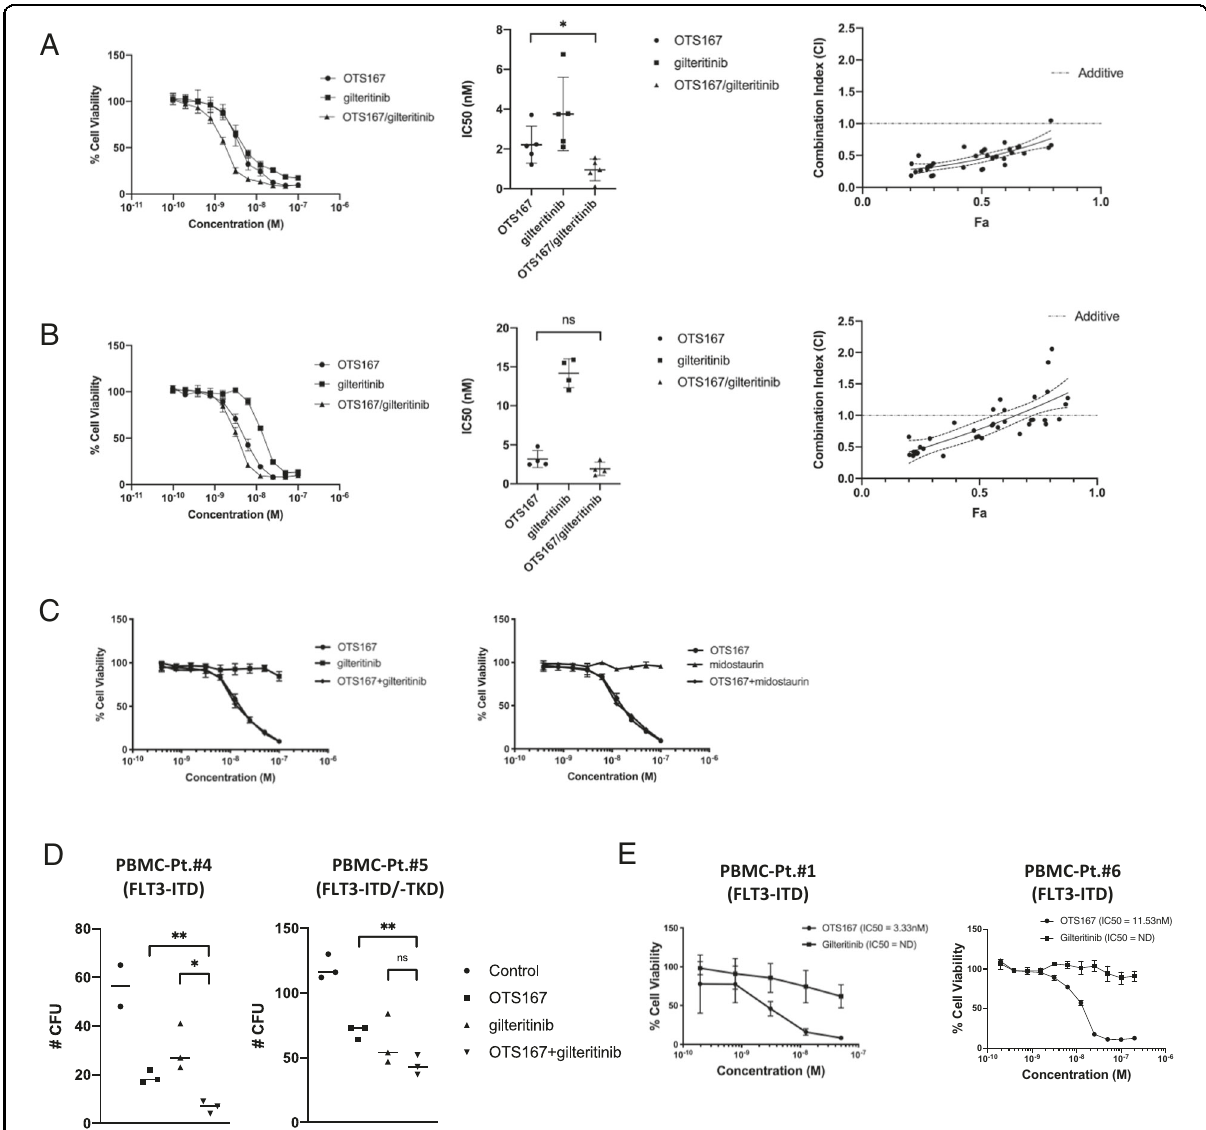
Fig. 5 OTS167 acts synergistically with TKIs to induce cell death in FLT3 mutant cell lines MV4:11 and MOLM-14. Representative cell viability assays (left panels), IC50 comparison (middle panels), and combination index (CI) graphs (right panels) for A MV4:11 and B MOLM-14 comparing single agent and combination (1:1) treatments at indicated doses. Combination index values were calculated using CompuSyn software. Combination index graphs (right panels) plot CI values at different cell viability percentages (Fa). Fa values between 0.2 (20% cell viability) and 0.8 (80% cell viability), representing the linear part of cell viability curves, are plotted. CI values <1 represent synergistic data points. Shown are linear regression curves with 95% con fi dence interval (dashed). IC50 comparison graphs represent 5 biological replicates (3 technical replicates) for MV4:11 ( A ) and 4 biological replicates (3 technical replicates) for MOLM-14 ( B ). Fa-CI plots (right panels) are individual data points (MV4:11 ( n = 36); MOLM-14 ( n = 37)) from 4 biological replicates for each cell line. C Representative cell viability assays for THP-1 (FLT3-WT) comparing indicated single agent and combination treatments. (2 biological replicates; 3 technical replicates). D Colony counts for colony-forming cell (CFC) assay using primary blasts obtained from two patients with FLT3 mutant AML. Left graph sample treated with 4 nM OTS167, 4 nM gilteritinib, or 4 nM dose of both drugs. Right graph sample treated with 1 nM OTS167, 1 nM gilteritinib or 1 nM dose of both drugs. (1 biological replicate per patient; 2 – 3 technical replicates per dose). E Cell viability assays for primary blasts obtained from two patients with TKI-resistant FLT3 mutant AML. (1 biological replicate per patient; 3 technical replicates per dose) (** P < 0.01, * P < 0.05, ns-not signi fi